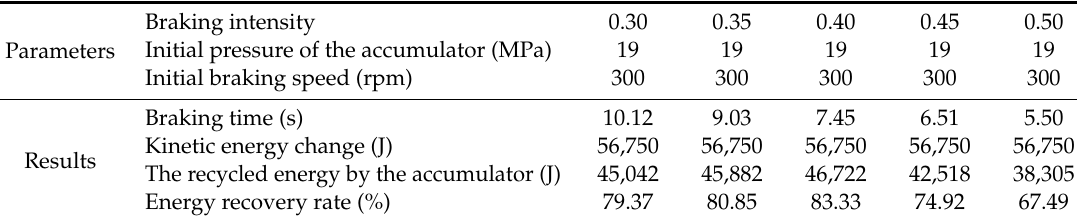
Table 6. The experimental results in the operating mode with di ff erent braking intensity.